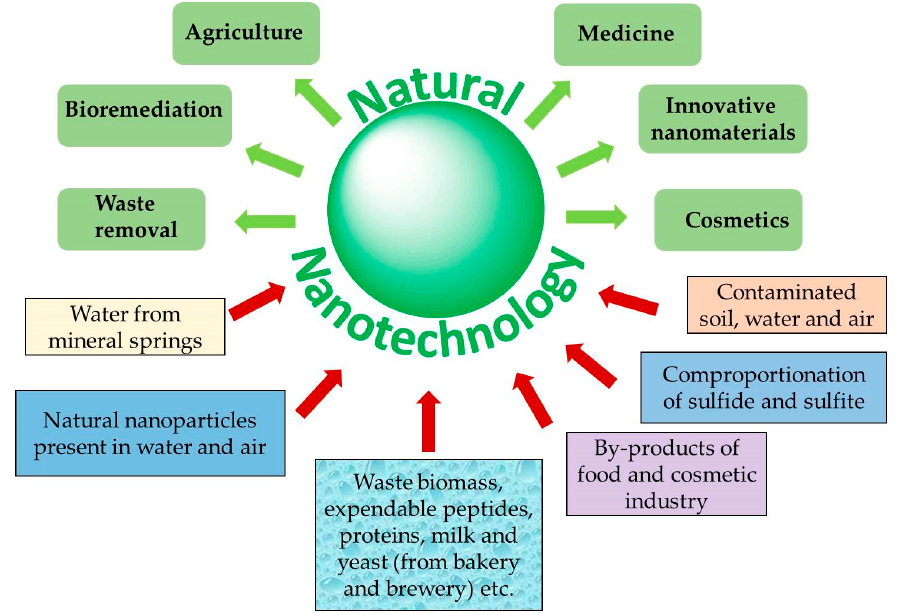
Figure 8. Natural nanotechnology with its various inorganic and biological aspects provides a wide range of opportunities and applications, not only in medicine and cosmetics, but also in less obvious areas such as agriculture and waste